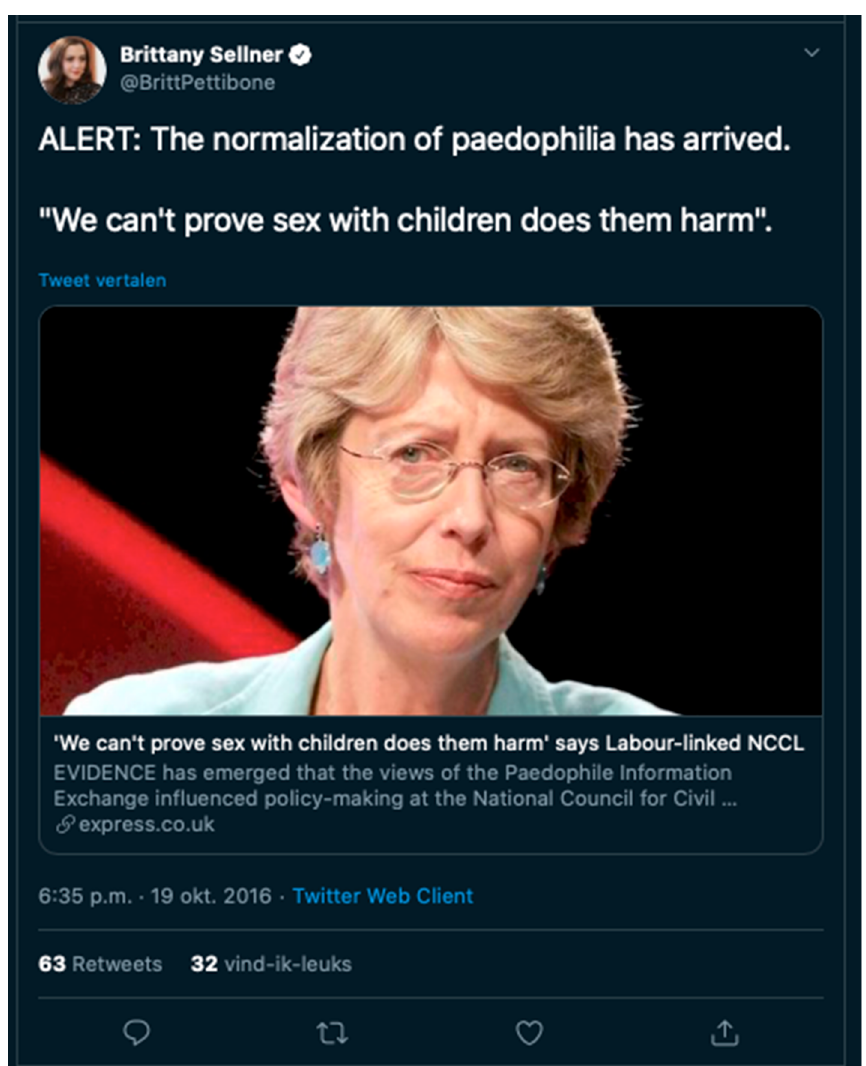
Figure 2. First tweet generating some uptake.